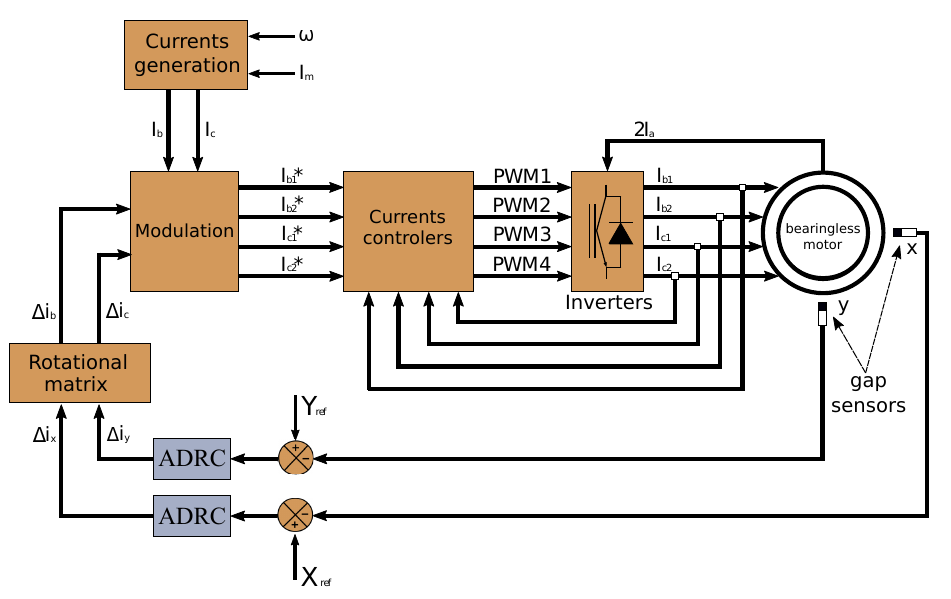
Figure 13. Control system